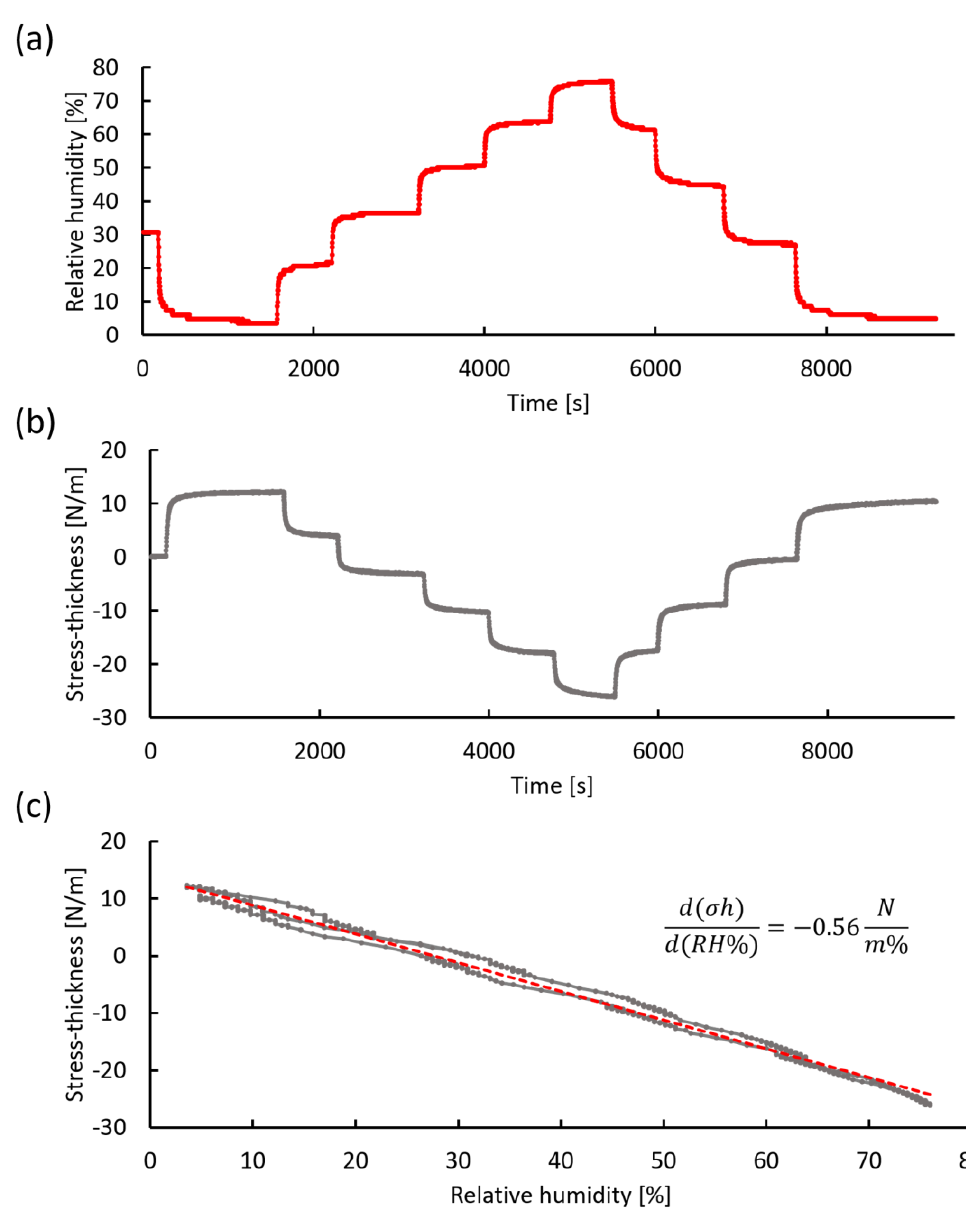
Figure 10. Humidity stress measurement using in situ cantilever curvature. ( a ) Change in relative humidity produced by mixing dry air and humidified air with a total flow rate of (500 ± 5) mL/min. ( b ) Stress-thickness response during humidity changes. ( c ) A plot (gray dots) of stress-thickness vs. relative humidity shown in (a) and (b). The red dotted line represents a linear regression line with a slope of − 0.56 N/(m%).